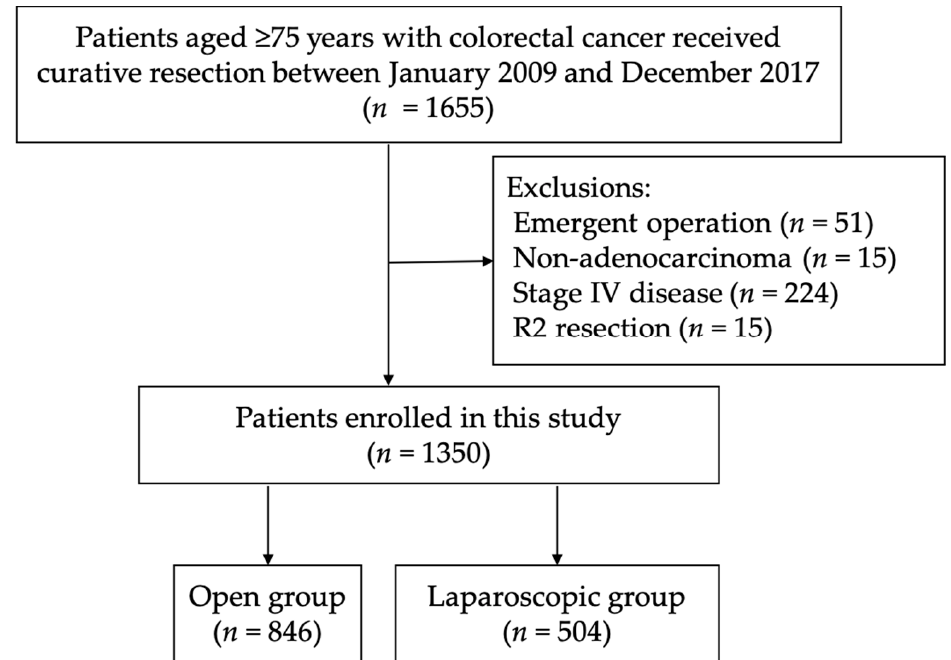
Figure 1. The Consort flow diagram of this study.